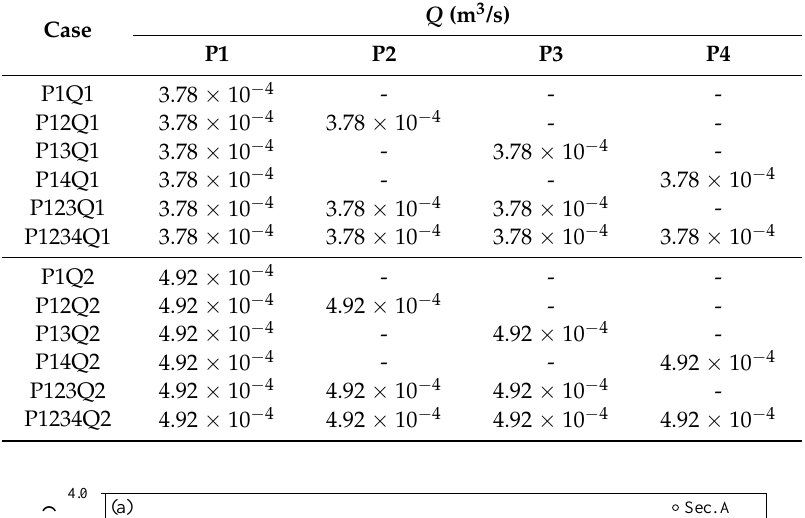
Table 1. Experimental conditions by flow inlet positions.